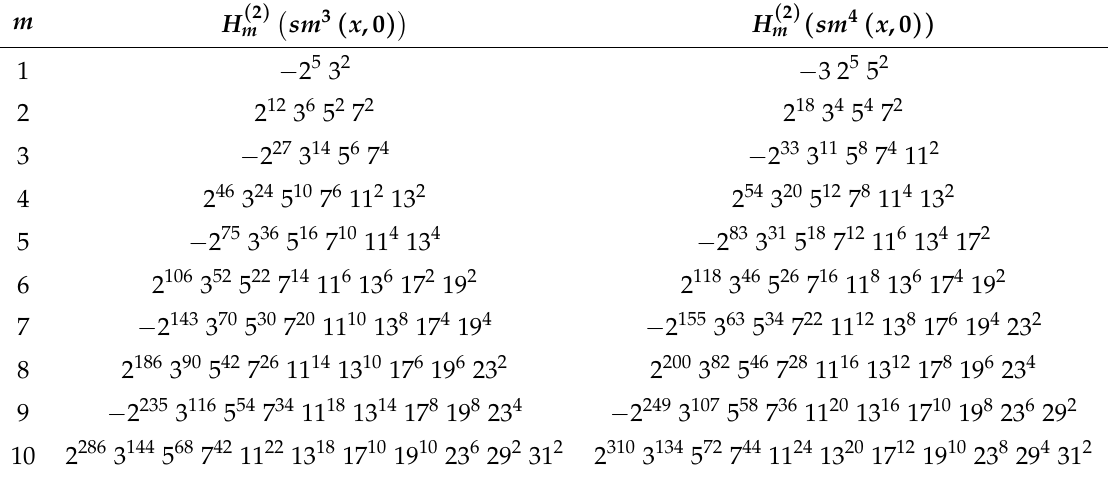
( 2 ) ( . ) of the Dixon elliptic functions sm 3 ( x ,0 ) and sm 4 ( x ,0 ) for m from m